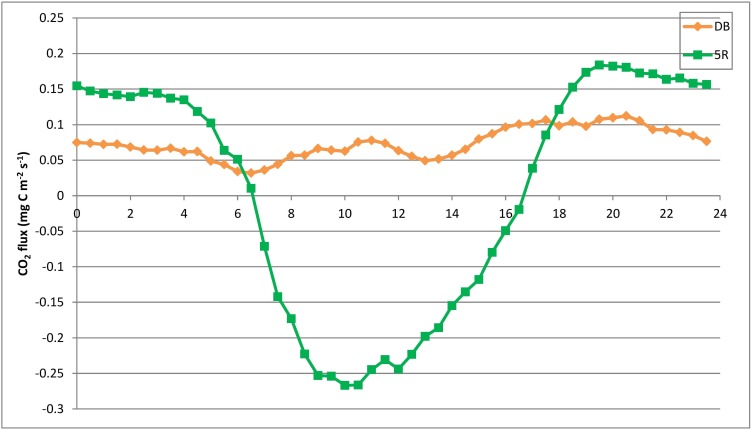
Diurnal patterns of the CO2 flux at 5R and DB.